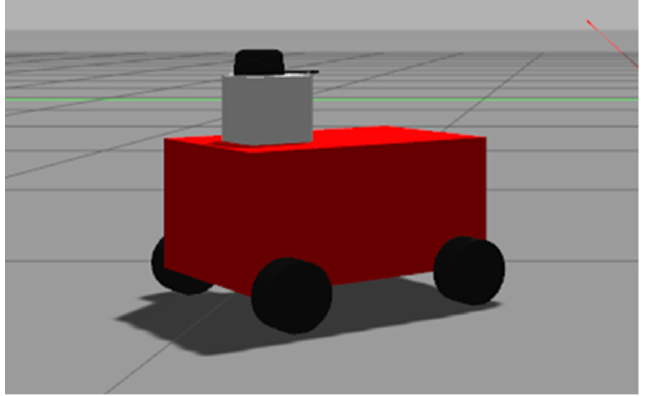
Figure 10. Four ‐ wheel robot model.